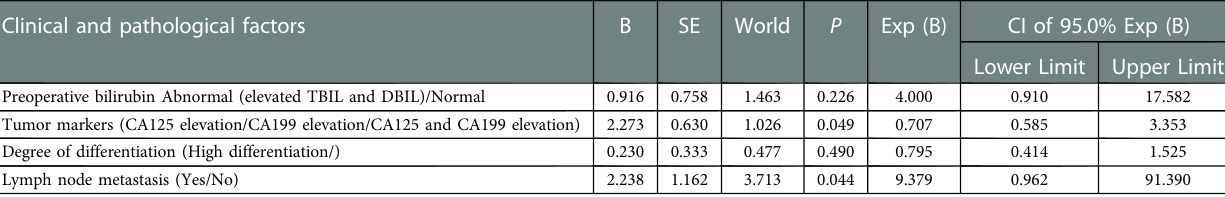
TABLE 4 Multivariate analysis of prognostic factors in patients with gallbladder carcinoma undergoing 4B+5 segment hepatectomy+cholecystectomy. Clinical and pathological factors